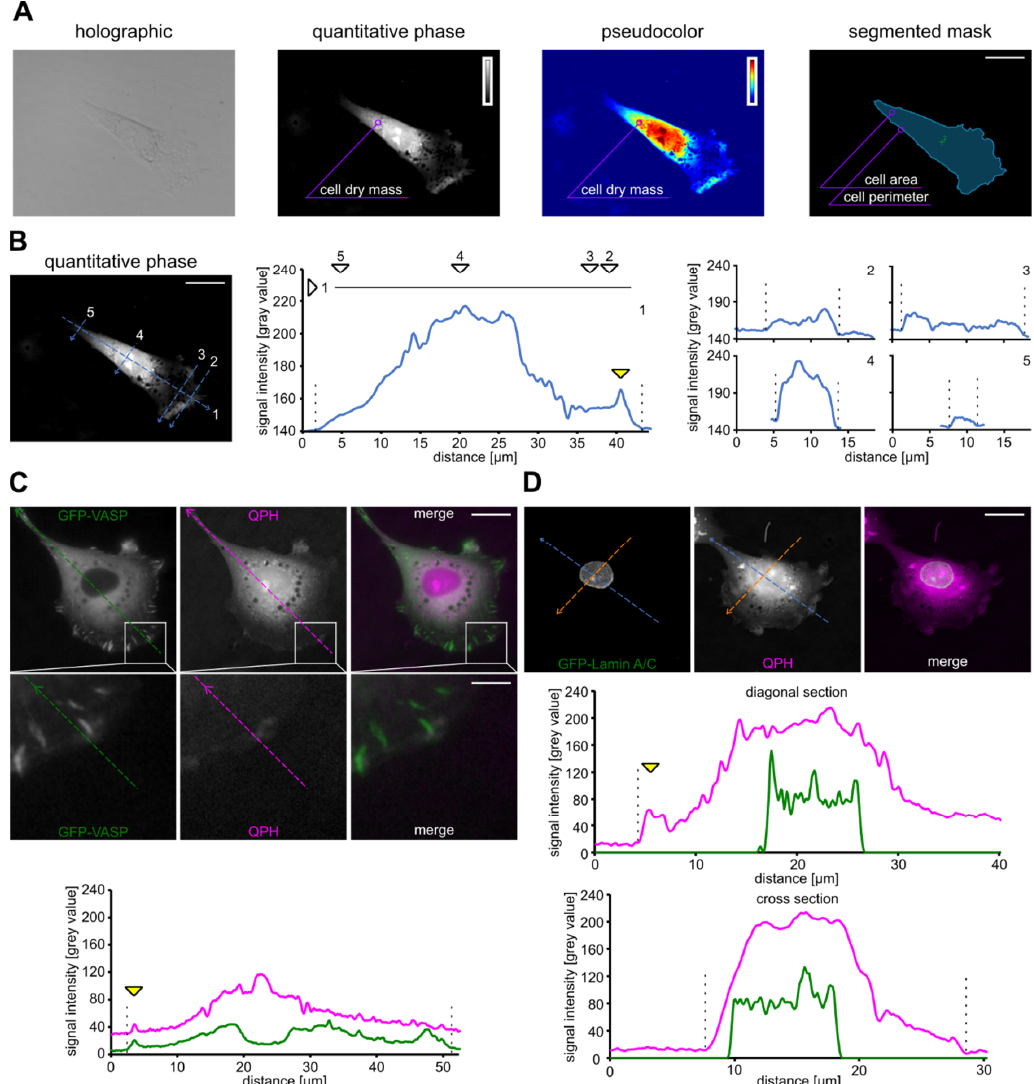
Figure 1. Coherence-controlled holographic microscopy generates quantitative phase images. ( A ) Examples of holographic, quantitative phase, pseudo-colored, and segmented images of a Rat2 fibroblast cell are shown. Cell dry mass distribution is displayed as the grayscale or pseudo-colored quantitative phase images (insets represent the signal intensity scale). Cell area/perimeter can be determined from the segmented mask. ( B ) The graphs show the distribution of signal intensities (i.e., cell dry mass) corresponding to respective diagonal (middle panel) and cross sections (right panel) of the imaged cell. The increase in dry mass at the leading edge is indicated by the yellow arrowhead. Cell borders are indicated by dashed lines. ( C ) GFP-VASP localization and its superposition with quantitative phase images of a Rat2 fibroblast cell are shown. The lower panel displays a higher magnification of the boxed area. The graph shows dry mass distribution and GFP-VASP intensity along the imaged cell. The yellow arrowhead indicates the increase in dry mass and GFP-VASP signal at the leading edge. Cell borders are indicated by dashed lines. ( D ) GFP-LaminA/C localization and its superposition with quantitative phase images of a Rat2 fibroblast cell are shown. The graphs display GFP-Lamin A/C signal intensity and dry mass distribution along the diagonal (blue) section and the cross (orange) section of the imaged cell. The yellow arrowhead indicates the increase in dry mass at the leading edge. Cell borders are indicated by dashed lines. Scale bars 10 μm ( A , B , C , D ), 2.5 μm (C—crop).